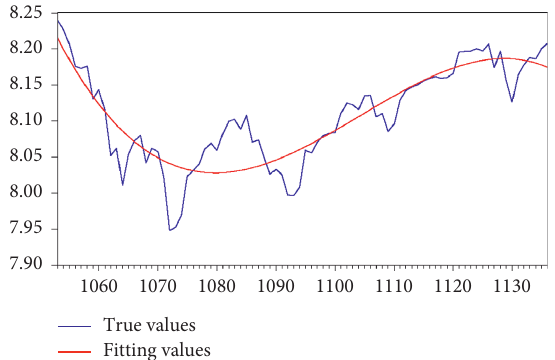
Figure 13: Fitting results from 2009/8 to 2009/11.